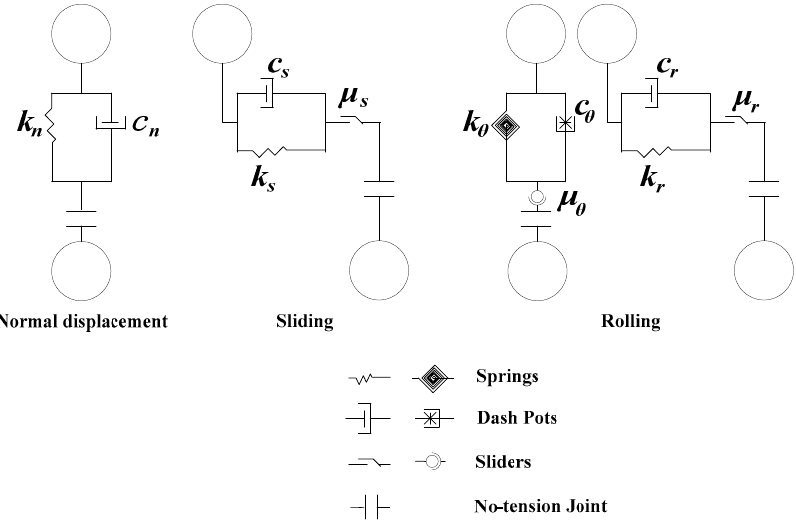
Figure 8. Contact model incorporating both rolling resistances and sliding frictional force (according to Tang et al., 2016).